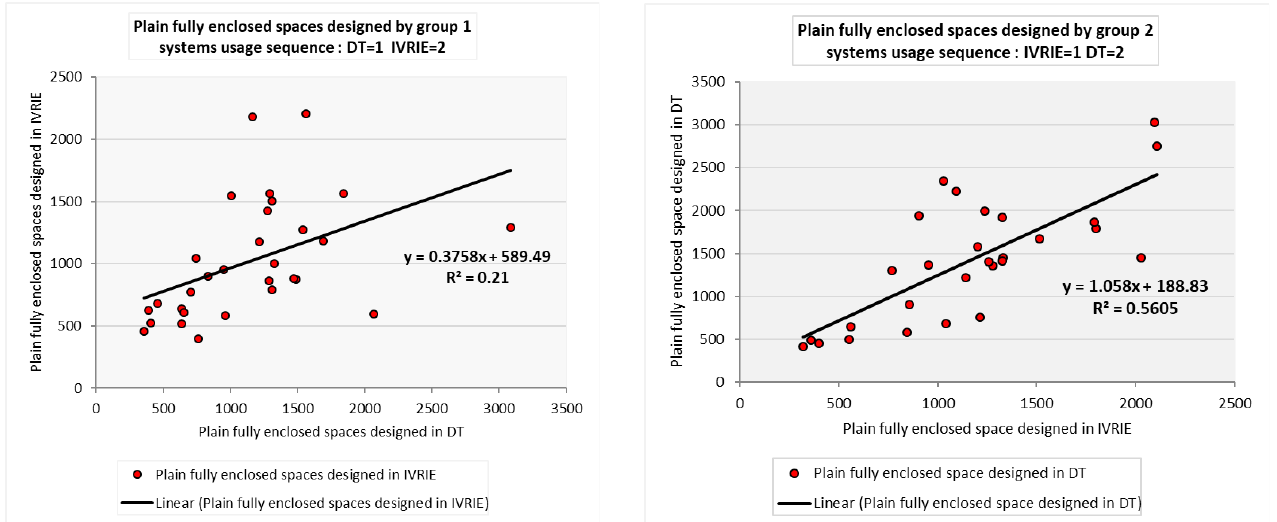
Figure 14. Linear regressions for plain, fully enclosed spaces designed by both groups in IVRIE and the DT system.